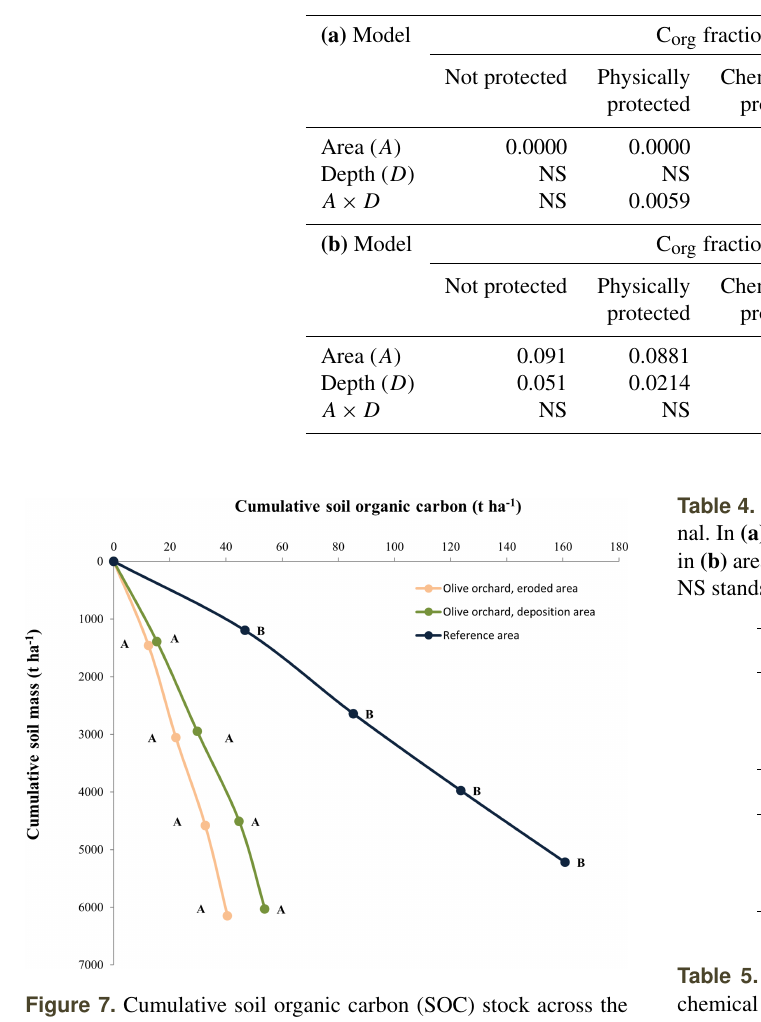
Figure 7. Cumulative soil organic carbon (SOC) stock across the soil profile in terms of cumulative soil mass on the vertical axis. Different letters for similar soil mass refer to statistically significant differences (Kruskal–Wallis test at p < 0 . 05). For this analysis cu- mulative soil organic carbons were interpolated linearly to the aver- age cumulative soil mass corresponding to all the points in the three areas.